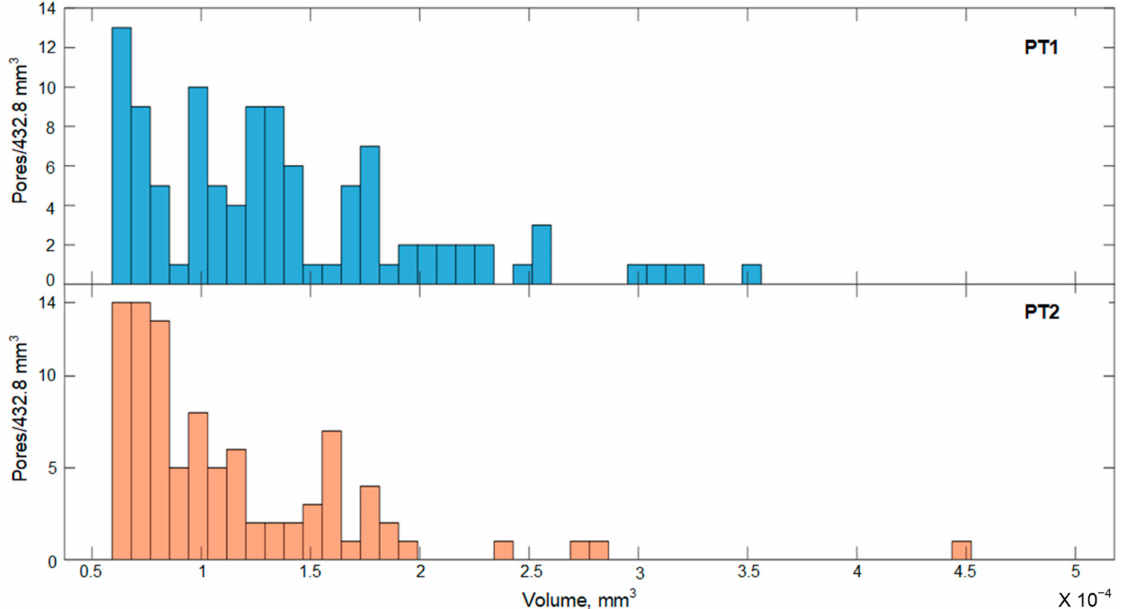
Figure 15. CT pore distribution histogram for the PT1 and PT2 specimens; no pores larger than 7.5 µ m in size were detected in the PT3